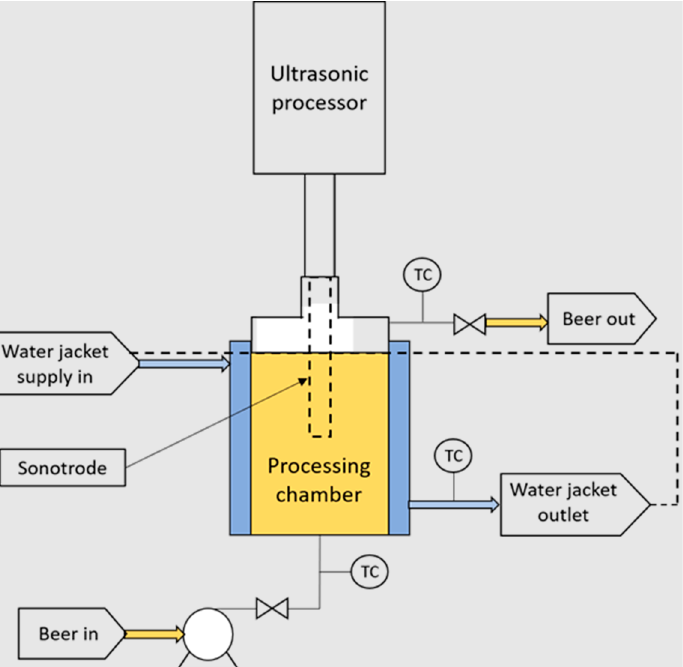
Figure 3. Schematic diagram of a continuous power ultrasonic (sonotrode) unit and cooling system. The thermocouples are referred to as TC on the diagram. Reprinted/adapted from [59]. 2023, Elham A. Milani and Filipa V.M. Silva.